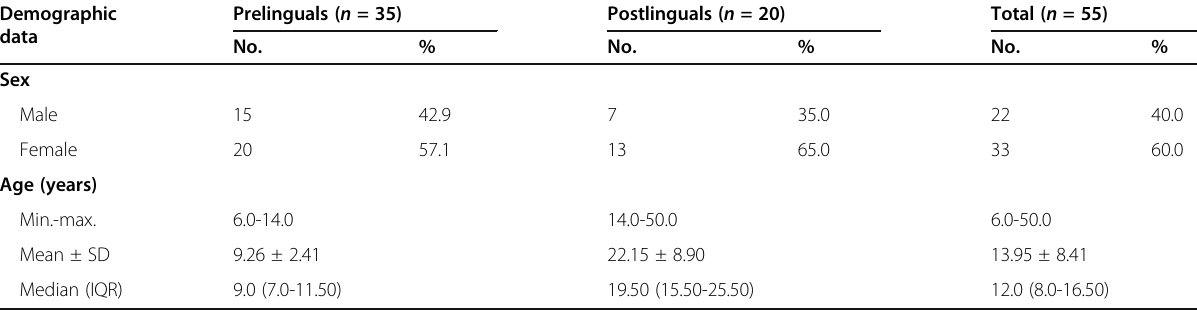
Table 1 Distribution of the studied cases according to their demographic data Demographic data